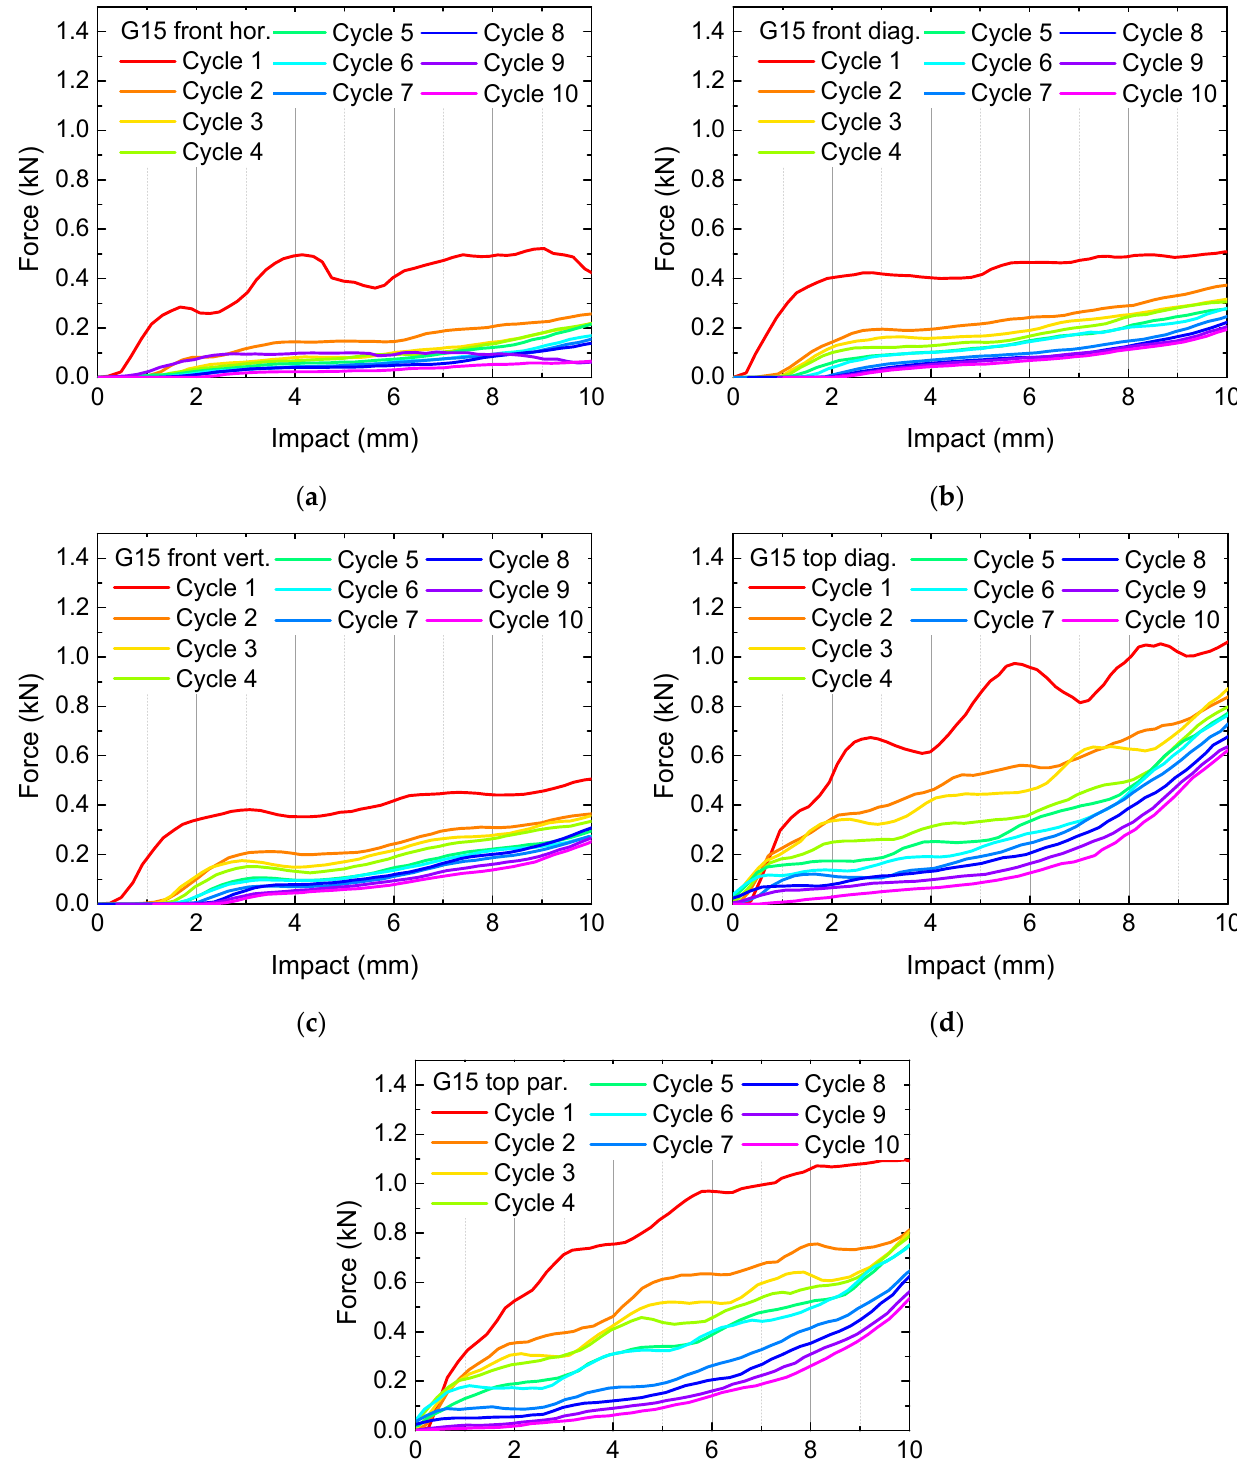
Figure 2. Quasi-static load tests in original state and after several test and recovery processes of samples G15: ( a ) front horizontal; ( b ) front diagonal; ( c ) front vertical; ( d ) top diagonal; ( e ) top parallel to the edges.